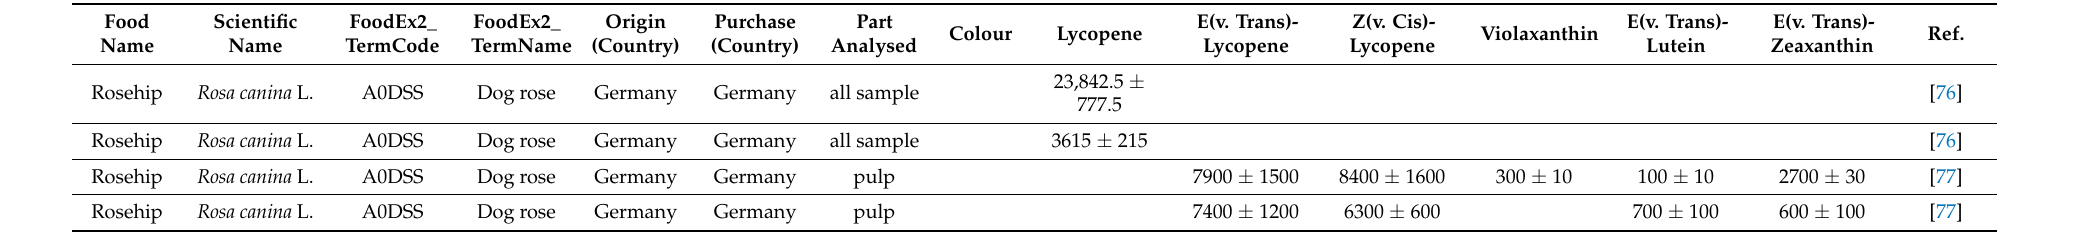
Table A7. Rose hips and similar (A01FR) ( µ g/100 g)